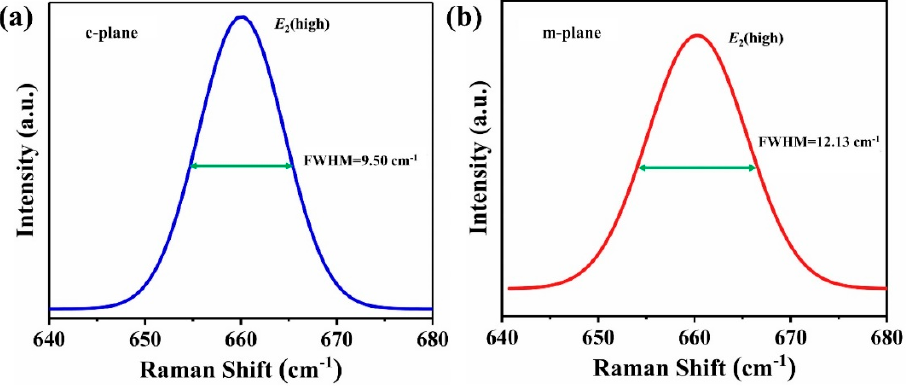
Figure 6. The FWHM of E 2 (high) mode of the c-plane ( a ) and m-plane ( b ). Table 2. The FWHM of E 2 (high) modes (cm − 1 ) of the prepared AlN seeds. c-Plane